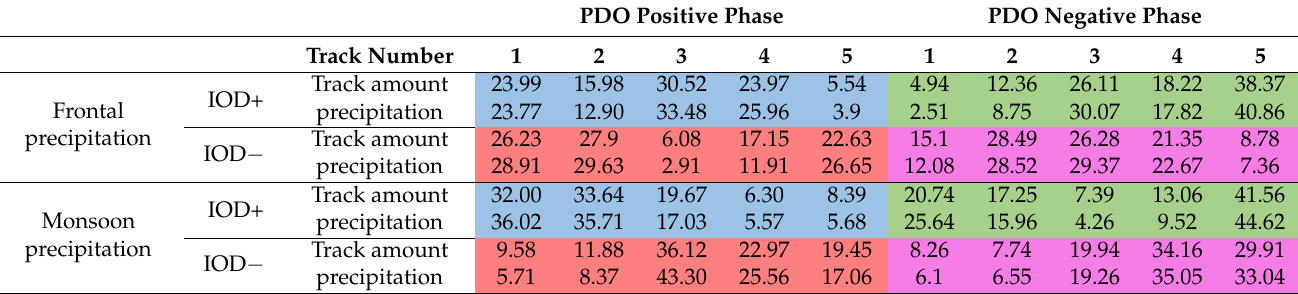
The Pacific Decadal Oscillation (PDO); the Indian Ocean Dipole Mode (IOD); the positive IOD phase (IOD+); the negative IOD phase (IOD −